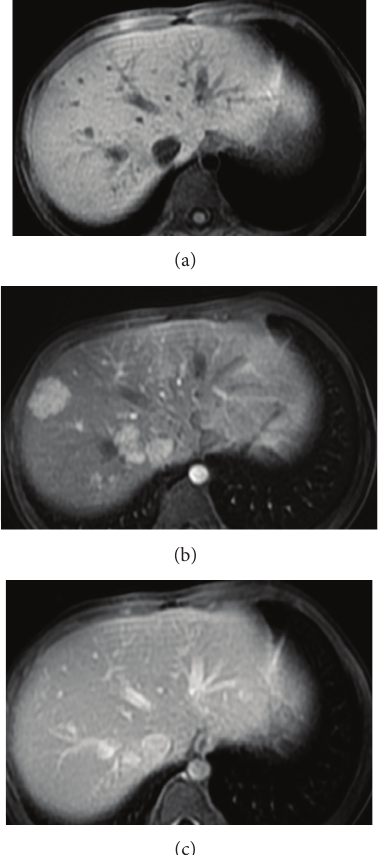
Figure 1: Nine-year-old girl with a history of metastatic right nephroblastoma treated with chemo- and radiotherapy. Liver MRI with T1-weighted images without (a) and with contrast injection at the arterial (b) and portal phases (c), performed six years after the end of treatment, displays multiple hepatic nodules, from 1 to 3cm large, that enhance strongly after contrast injection at the arterial phase (b) and have almost the same signal as the surrounding liver before contrast injection (a) and at the portal phase (c). Simple clinical and imaging followup was performed (courtesy of Dr.